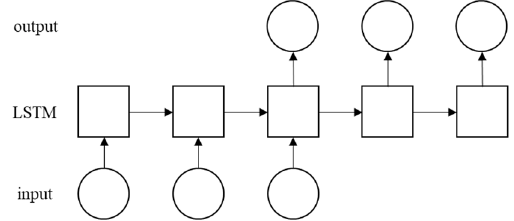
Figure 4. Many-to-many LSTM RNN Architecture.